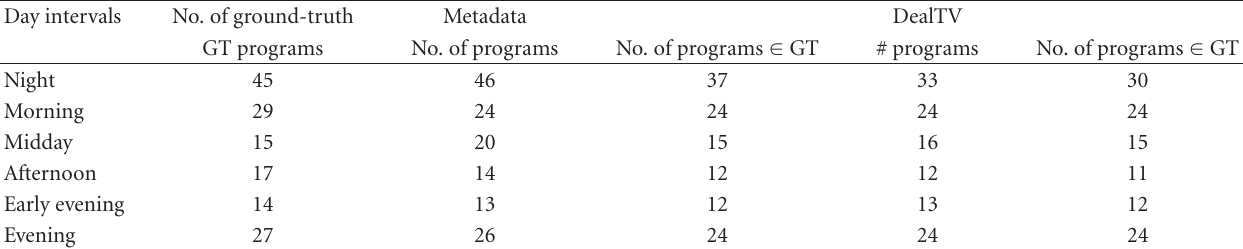
Table 7: TVTest . The number of long programs in the Ground-Truth—programs mentioned in the metadata—extracted programs by DealTV.